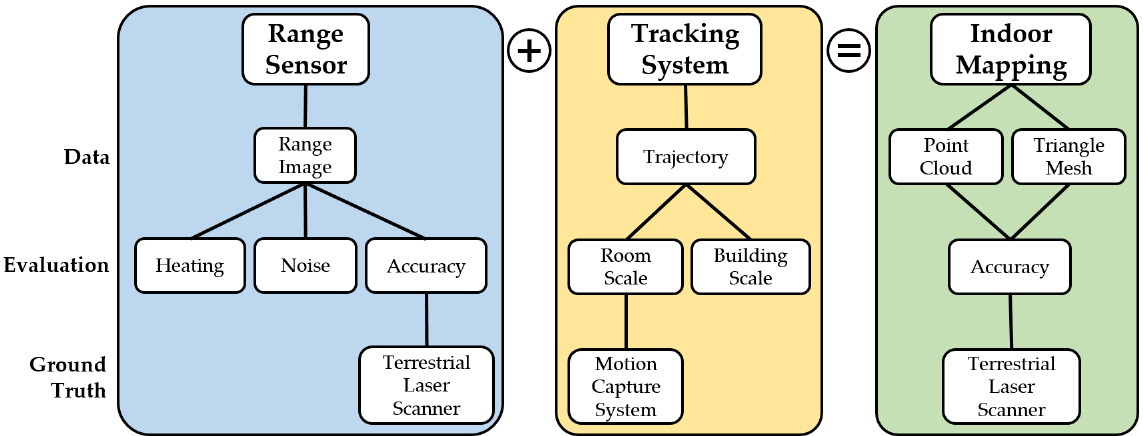
Figure 1. Schematic overview of the evaluation of the Microsoft HoloLens as indoor mapping system with range sensor and tracking system as the relevant subsystems constituting